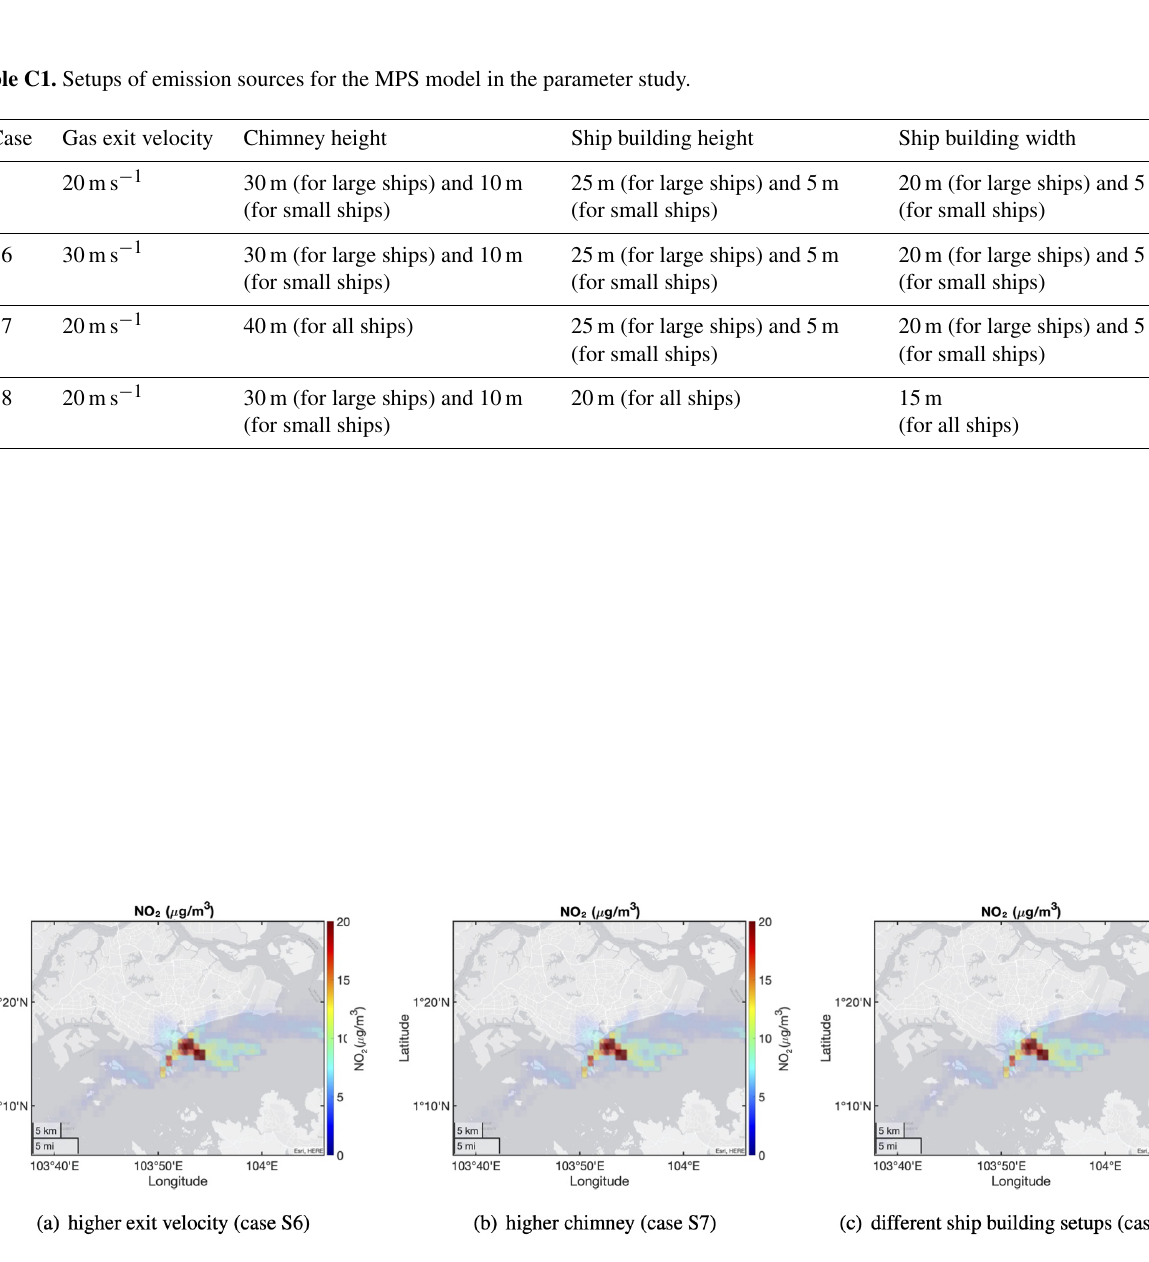
Figure C1. Instantaneous NO 2 concentrations near the ground by using different emission